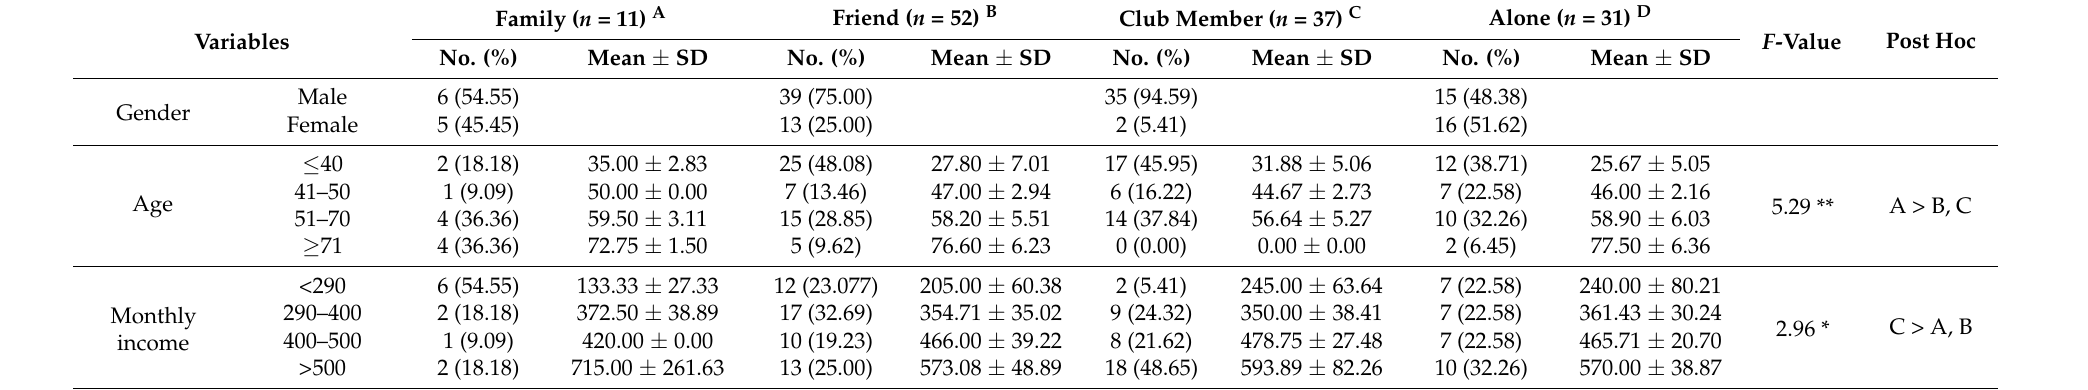
Table 2. Characteristics for participants who were injured during PA in a